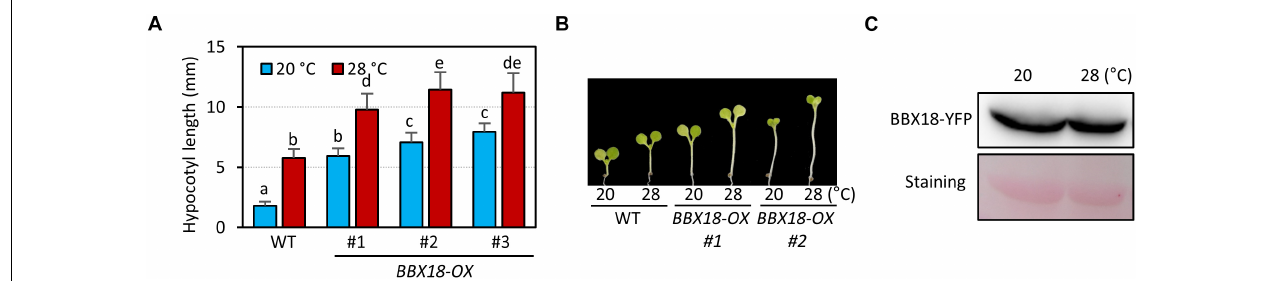
FIGURE 1 | Overexpression of BBX18 promotes hypocotyl growth at normal and high temperatures. (A,B) Hypocotyl lengths of the seedlings [wild-type (WT) and BBX18-OX plants] grown under continuous white light at 20 ◦ C for 7 days or at 20 ◦ C for 4 days followed by 28 ◦ C for 3 days. Letters above the bars indicate significant differences based on one-way ANOVA and Tukey’s test ( P < 0.05). Representative seedlings are shown in (B) . (C) Levels of BBX18-YFP in BBX18-OX plants were not affected by high temperatures. BBX18-OX plants were grown under white light constitutively at 20 ◦ C or grown at 20 ◦ C and shifted to 28 ◦ C for 24 h.